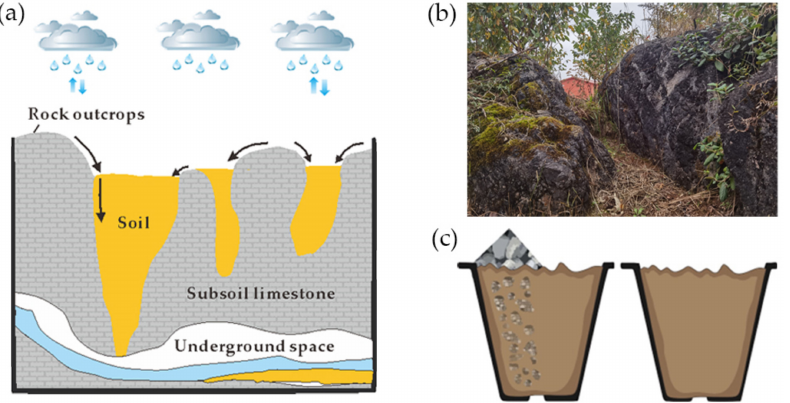
Figure 1. Illustration of karst rock outcrops. ( a ) Profile of soil water loss in rock outcrops. ( b ) Field karst rock outcrops. ( c ) Experimental